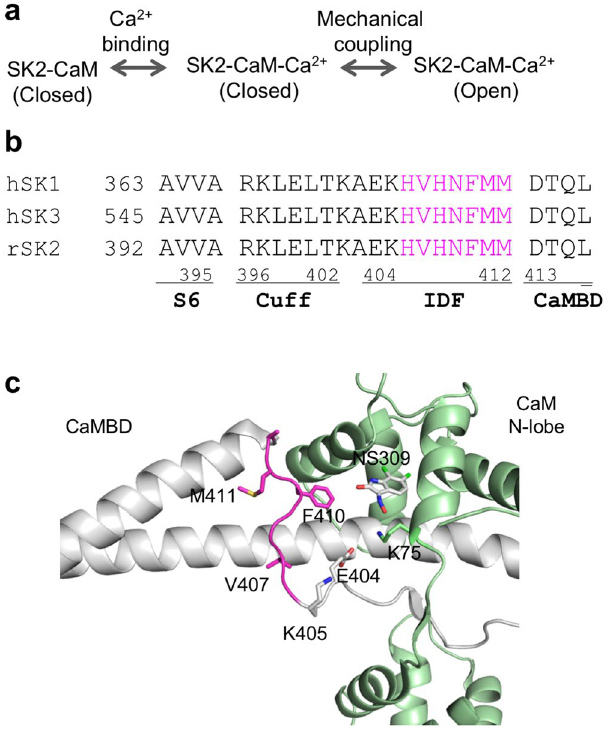
Figure 1. The SK channels IDF connects the CaMBD and transmembrane domain S6. ( a ) A simplified gating scheme for Ca 2 + -dependent SK channel activation may include two steps: (1) binding of Ca 2 + to CaM associated with the SK channel and (2) mechanical coupling between Ca 2 + binding to CaM and subsequent channel opening. ( b ) Amino acid sequence alignment of mammalian SK channels at the region connecting the CaMBD and the S6 transmembrane domain. Seven amino acid residues from the IDF shown in magenta are the focus of this study. Human and rat sequences are identical at this region. ( c ) Seven residues from the IDF (in magenta) are located between the CaMBD and the transmembrane S6